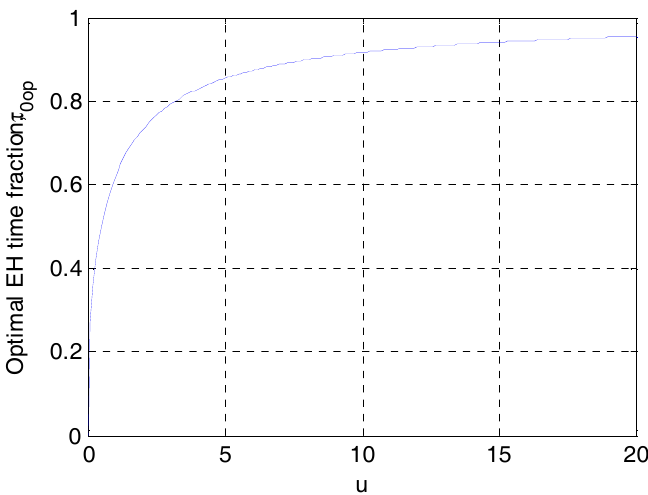
Figure 2. The optimal energy harvesting (EH) time fraction as a function of u .